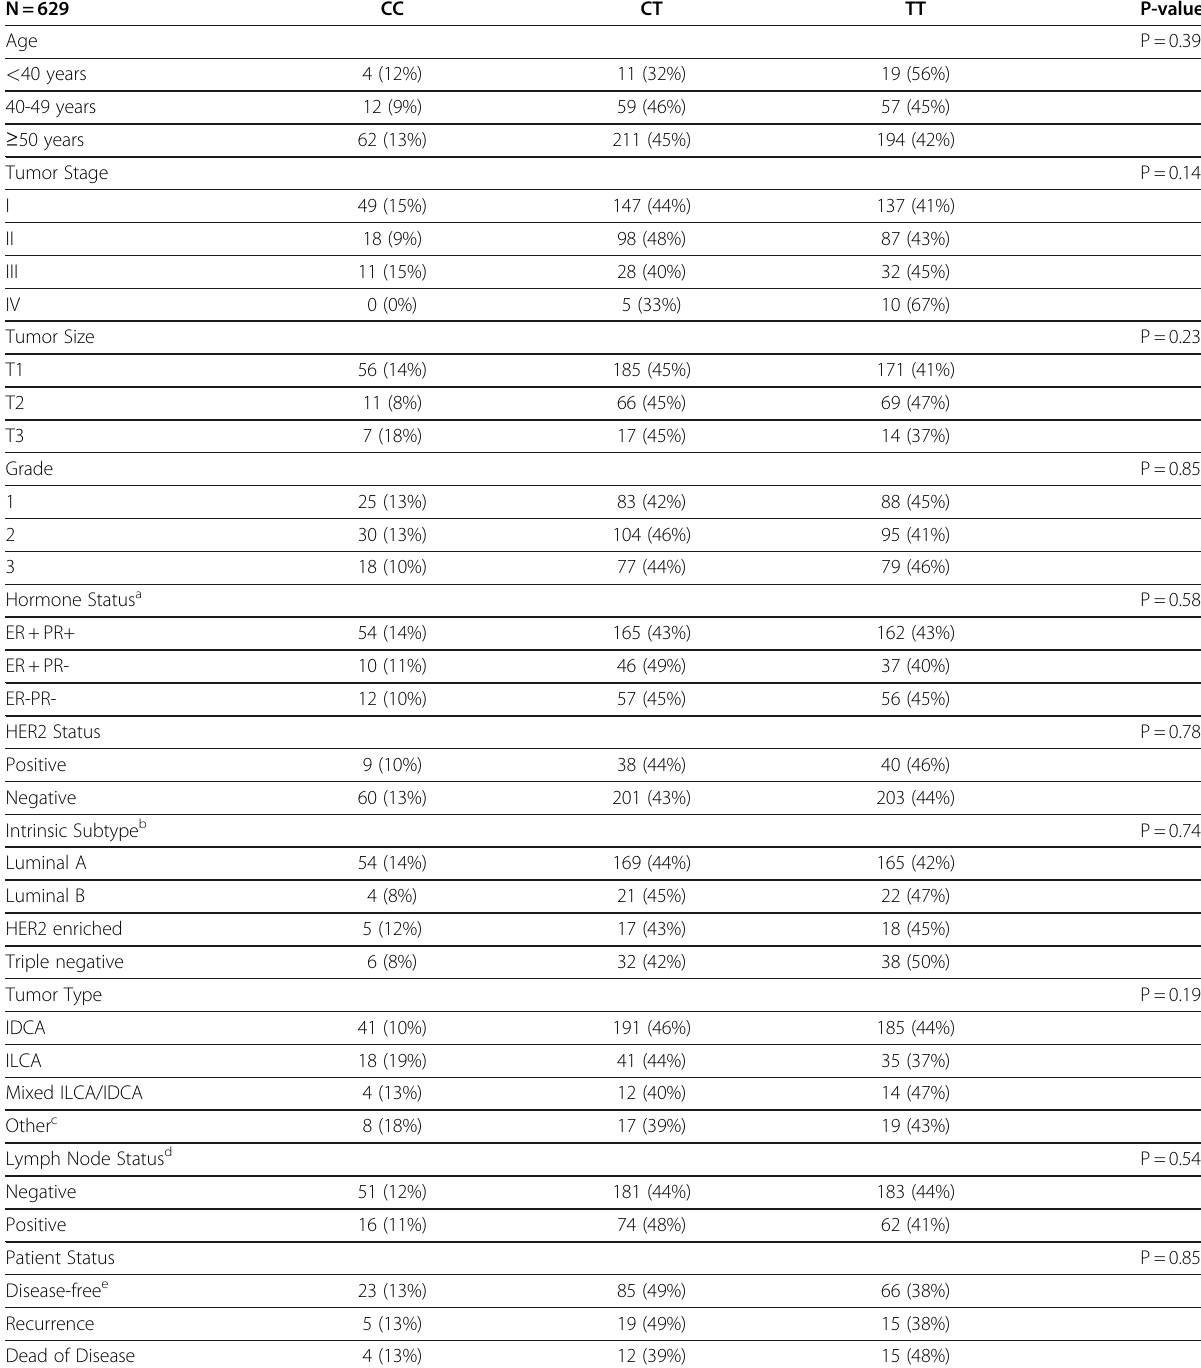
Table 1 Genotype frequencies by clinicopathological